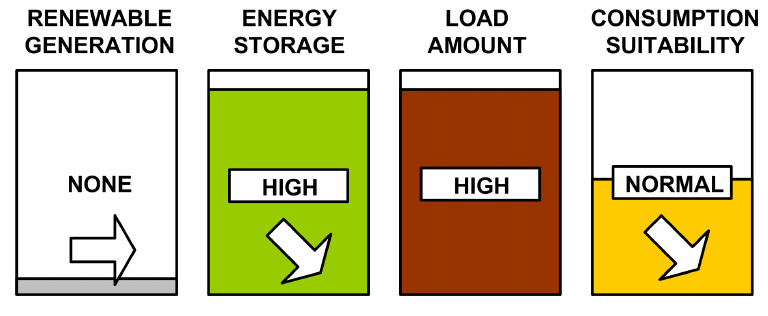
Figure 6. Example of system feedbacks addressed to users. Arrows mark predicted evolution or